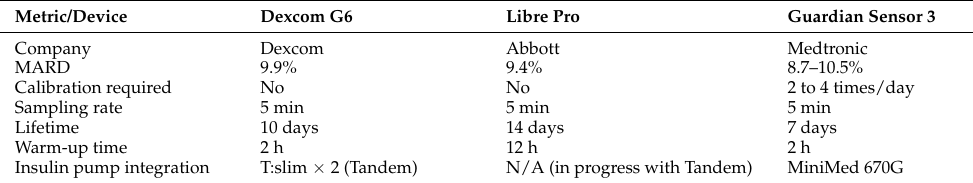
Table 1. Current CGM